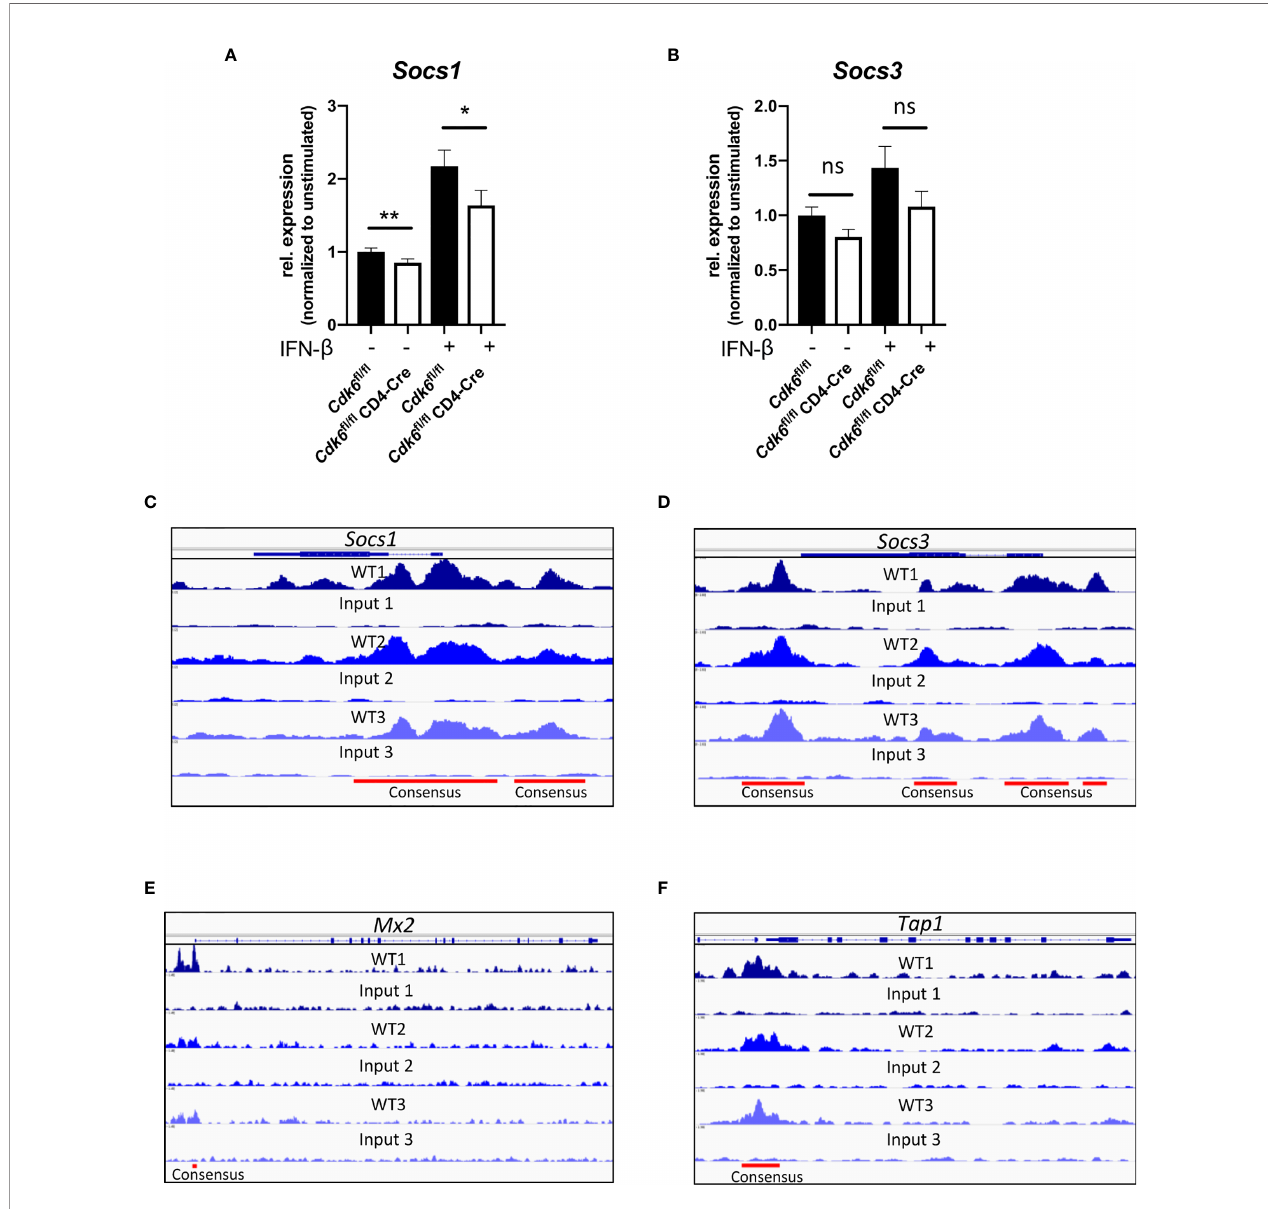
FIGURE 7 | CDK6 regulates negative feedback loops of type I IFN signaling. (A, B) Splenic CD8+ T cells were isolated from Cdk6 fl / fl and Cdk6 fl / fl CD4-Cre mice and activated with a CD3/ a CD28 for 48h in the presence of IL-2. Cultured CD8+ T cells were kept unstimulated or stimulated with 10U/ml IFN- b for 2h. Cells were lysed and relative expression levels (normalized to Ube2d2 as a house-keeping gene) of Socs1 (A) and Socs3 (B) were analyzed by qPCR. Relative expression values are shown normalized to unstimulated Cdk6 fl / fl controls (n=6). (C – F) CDK6 ChIP-seq was performed in p185 BCR-ABL -transformed B cell lines (12). CDK6 ChIP-seq peaks at the Socs1 (C) , Socs3 (D) , Mx2 (E) and Tap1 (F) loci are shown. Input samples are shown as controls. Consensus peaks are indicated with lines. (A, B) Bar graphs represent mean ± SEM, pooled from three independent experiments, **p < 0.01, *p < 0.05, paired t-test. ns, not signi fi